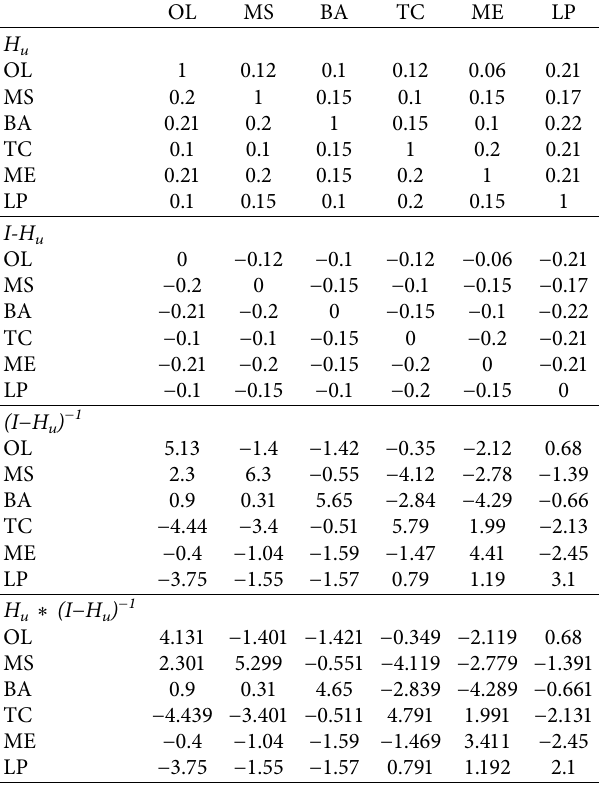
Table 8: Generation of the u matrix of general relationships for activities.